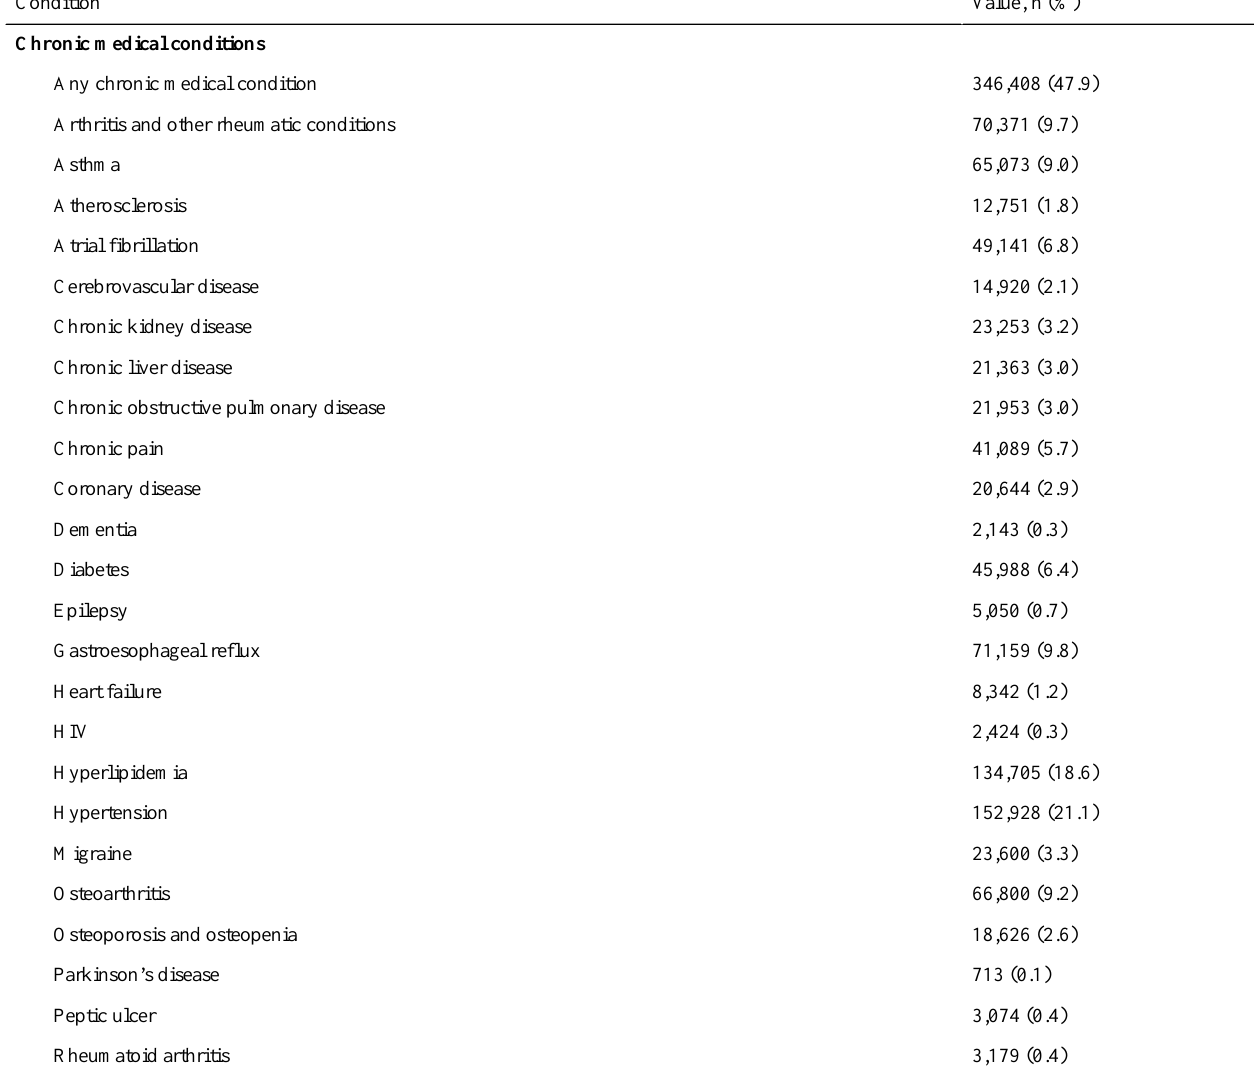
Table 3. Diagnoses a of patients in the Kaiser Permanente Northern California Adult Alcohol Registry (N=723,604).